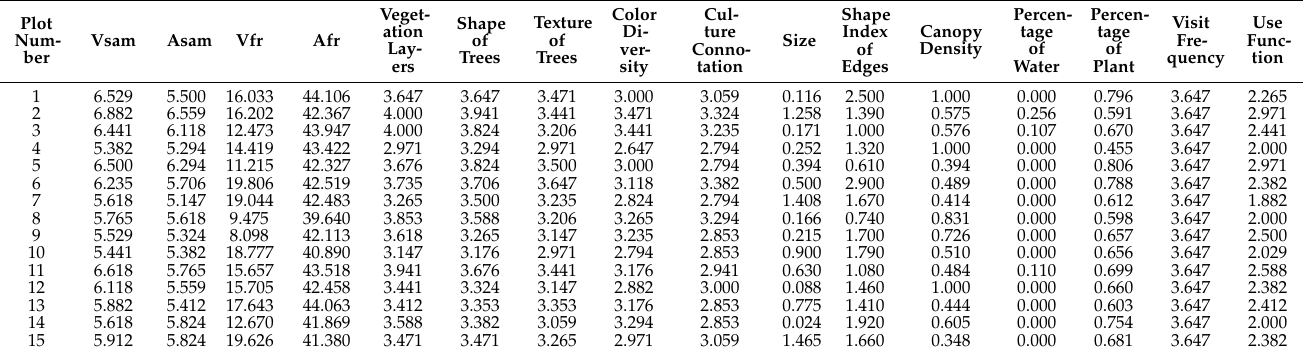
Table A1. Descriptive statistics for sample plots.